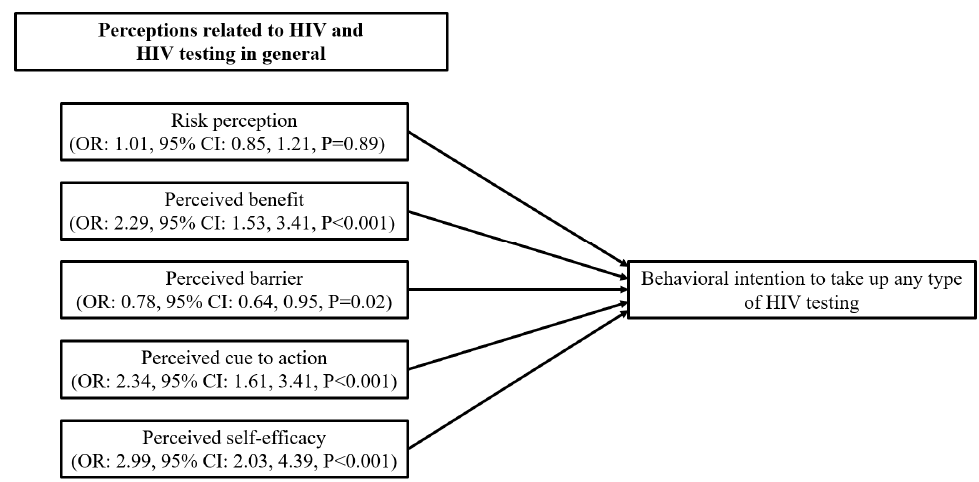
Figure 1. Factors associated with behavioral intention to take up any type of HIV testing.